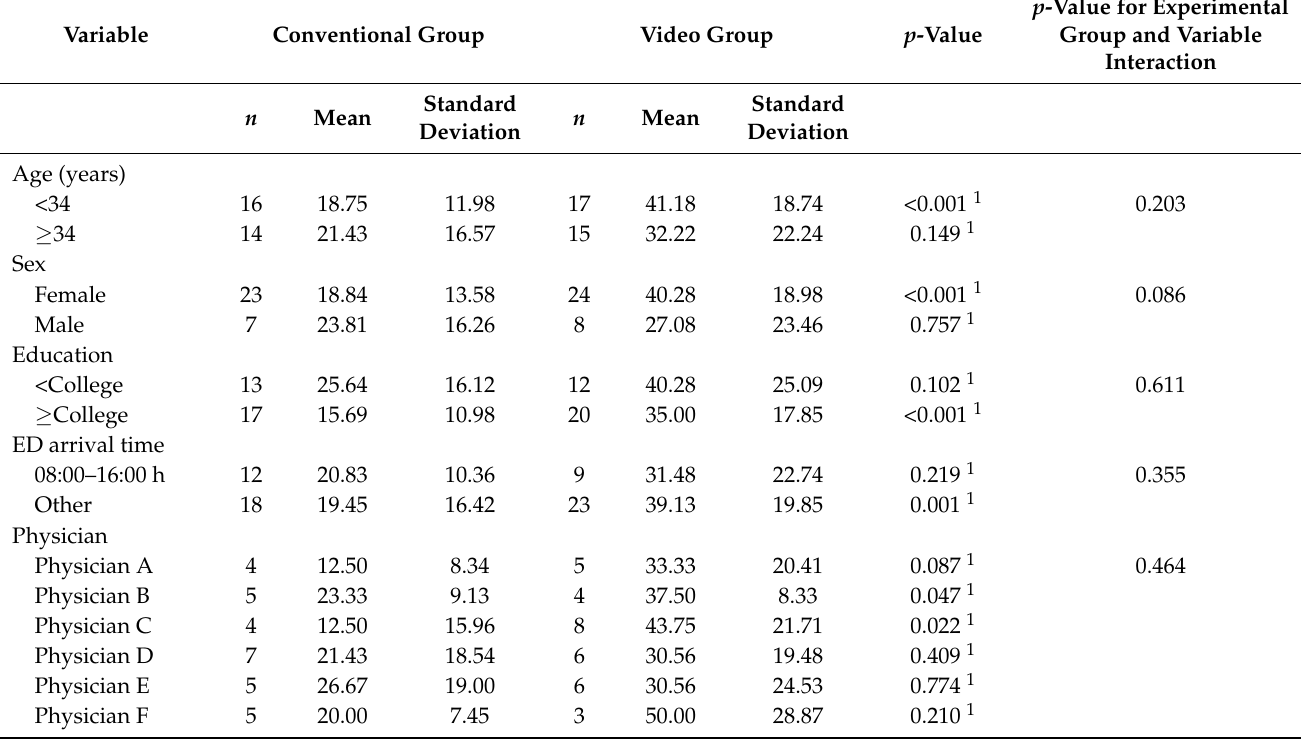
Table 2. Subgroup analysis for the knowledge score